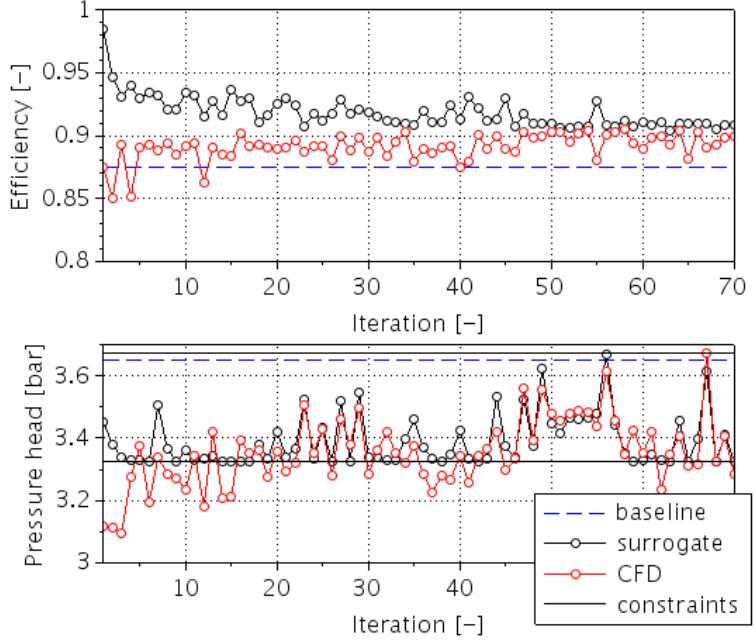
Figure 12. Evaluation of the design from the SOGA with the surrogate and CFD simulation: efficiency ( top ) and total pressure head ( bottom ).